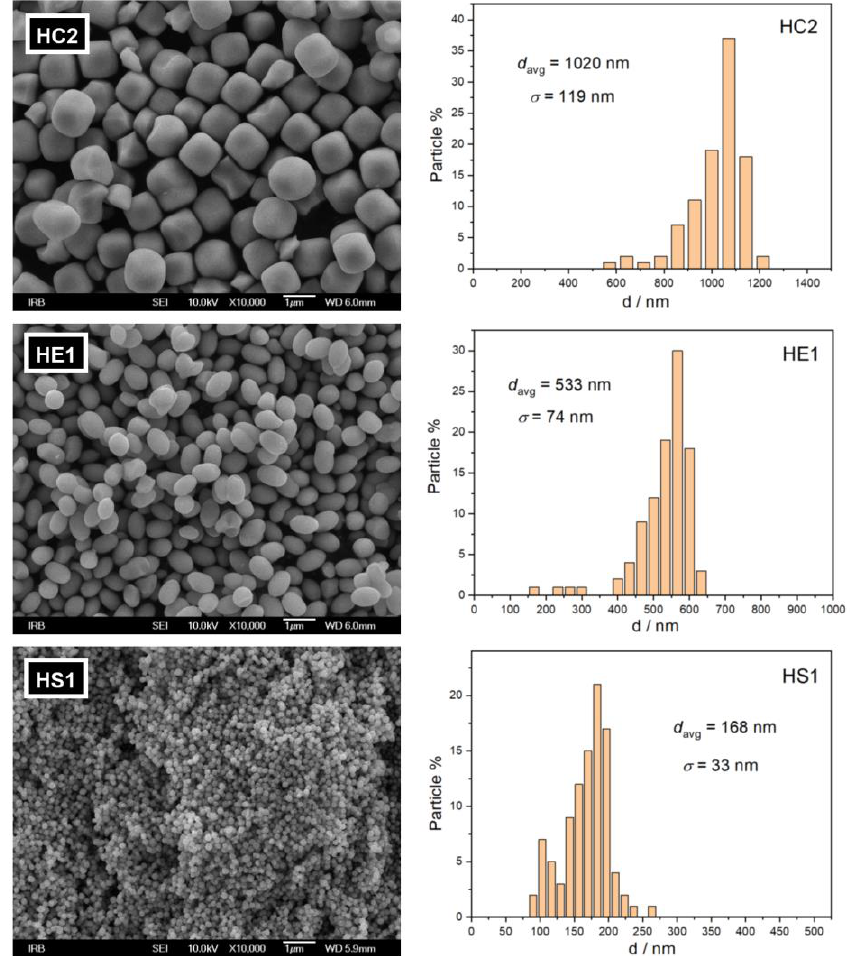
Figure 2. FE-SEM images of synthesized hematite samples, HC2, HE1, and HS1, with corresponding particle size (diameter) distributions.